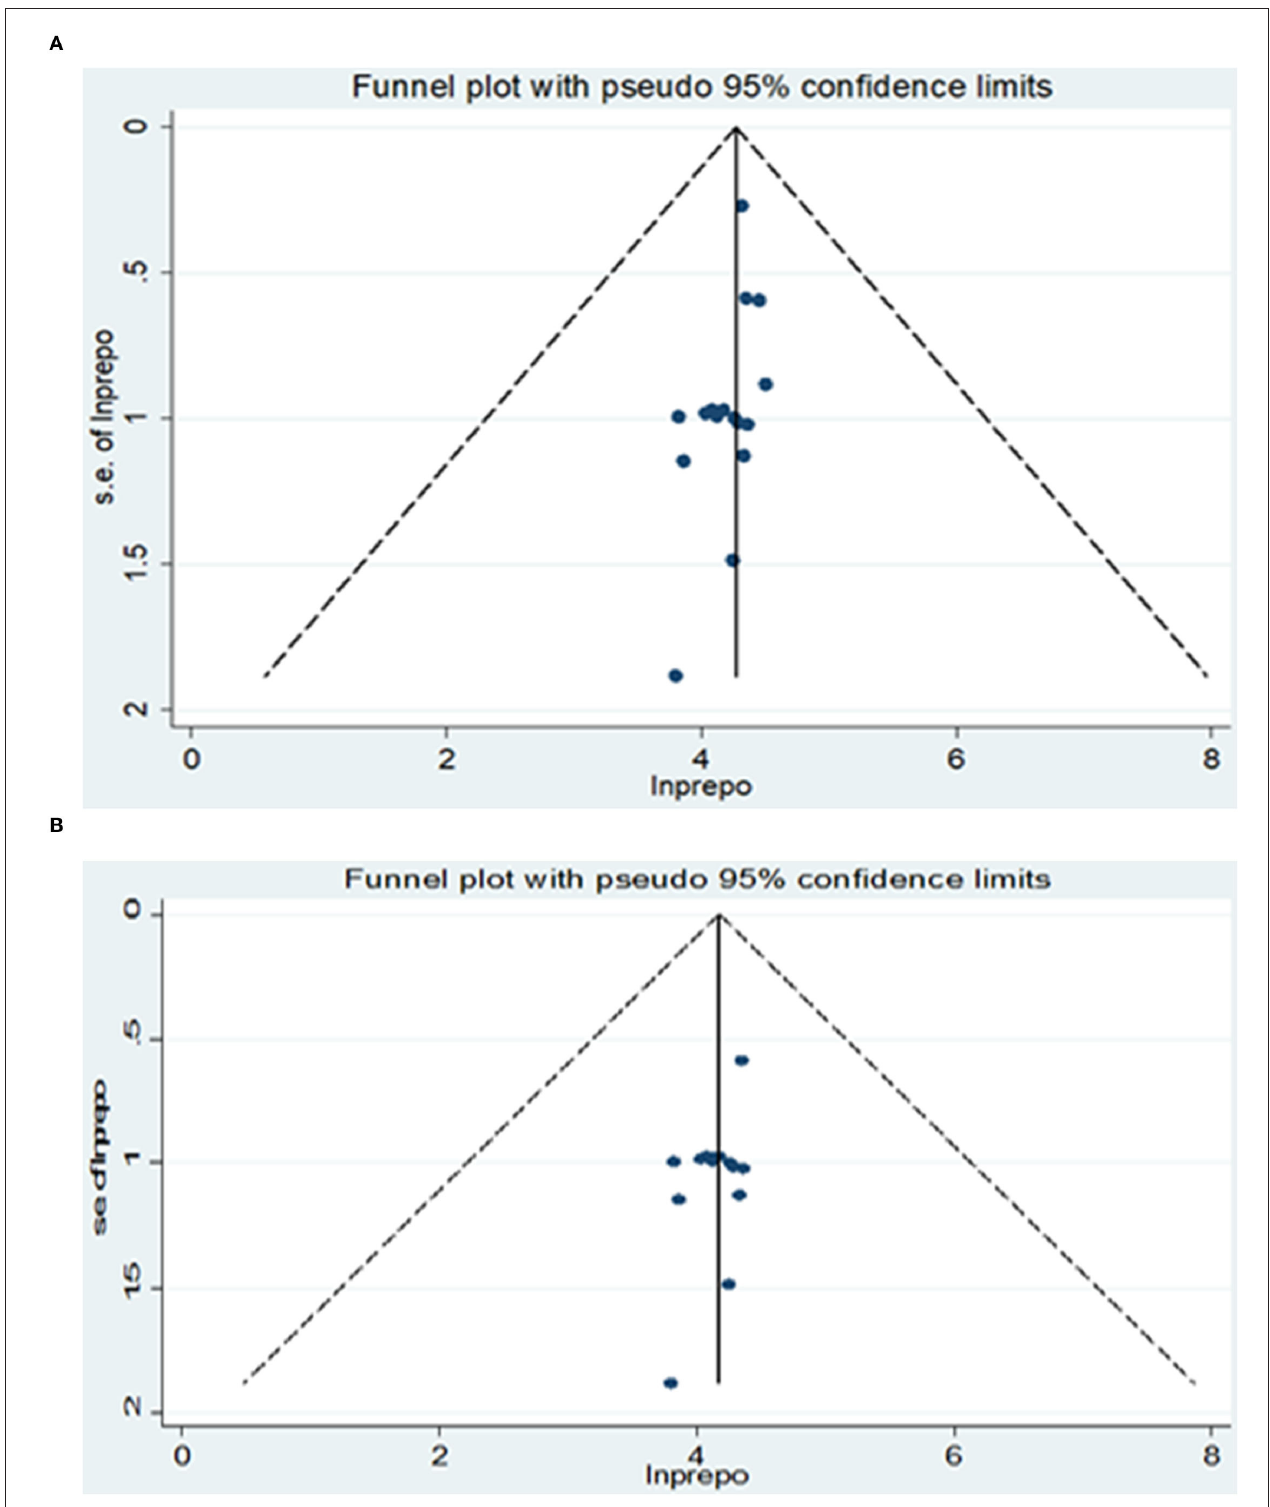
FIGURE 2 | (A) Funnel plot for publication bias of 17 primary studies to estimate the pooled prevalence of PAFP utilization in Ethiopia. (B) Funnel plot for publication bias of 17 primary studies to estimate the pooled prevalence of PAFP utilization in Ethiopia.